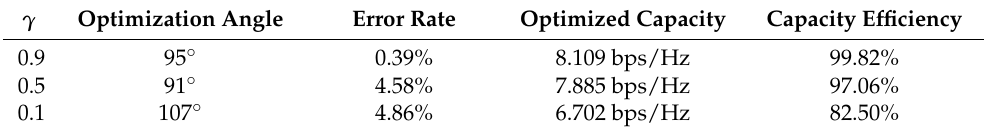
Table 9. Optimized values for antenna downtilt and channel capacity with different discount rates at D = 250